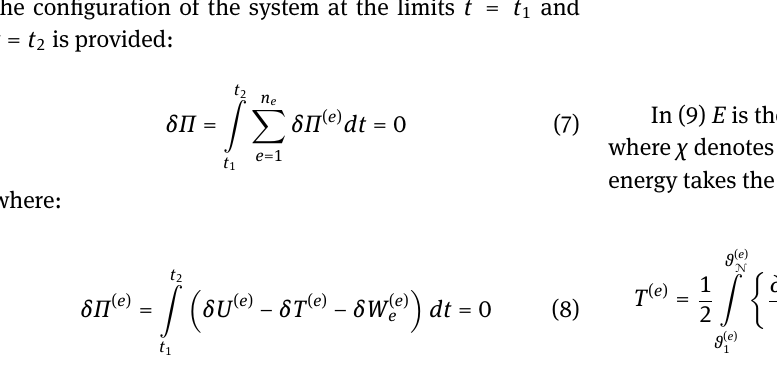
among the set of all admissible configurations of the sys-